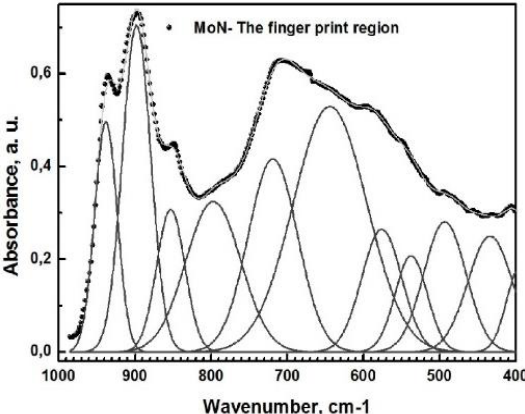
Fig. 3. FTIR (Fourier-transform infrared) spectra of the MoN films in the 400-1000 cm −1 fingerprint region.